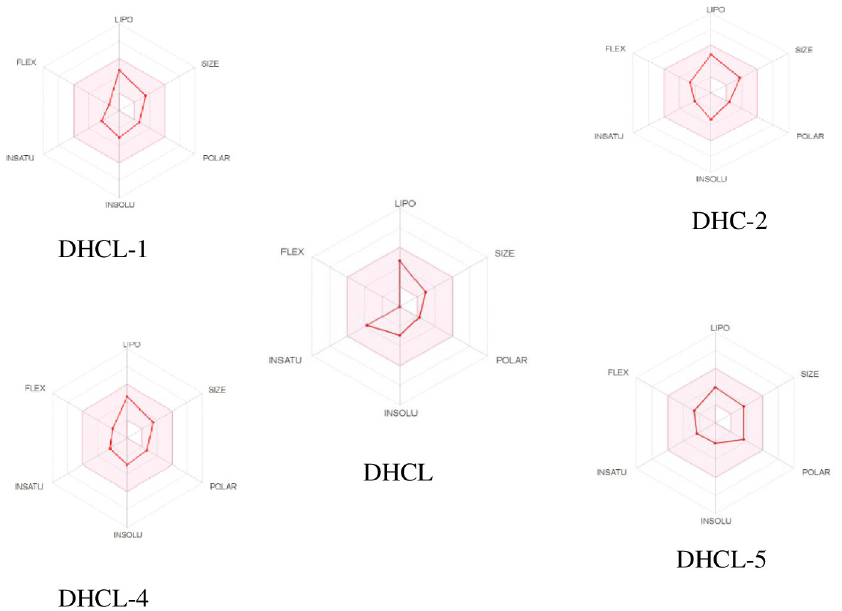
Fig 3. Bioavailability radar of the cytotoxic compounds. Note : The pink region indicates the optimal range for the properties predicted (size: Molecular weight between 140 and 400 g/mol, polarity: TPSA between 19 and 130 Å 2, lipophilicity: XLOGP3 usually between − 0.69 and + 4.9, saturation: fraction of carbons in the sp3 hybridization not less than 0.25, solubility: log S not higher than 6, and flexibility: no more than 9 rotatable bonds [24].